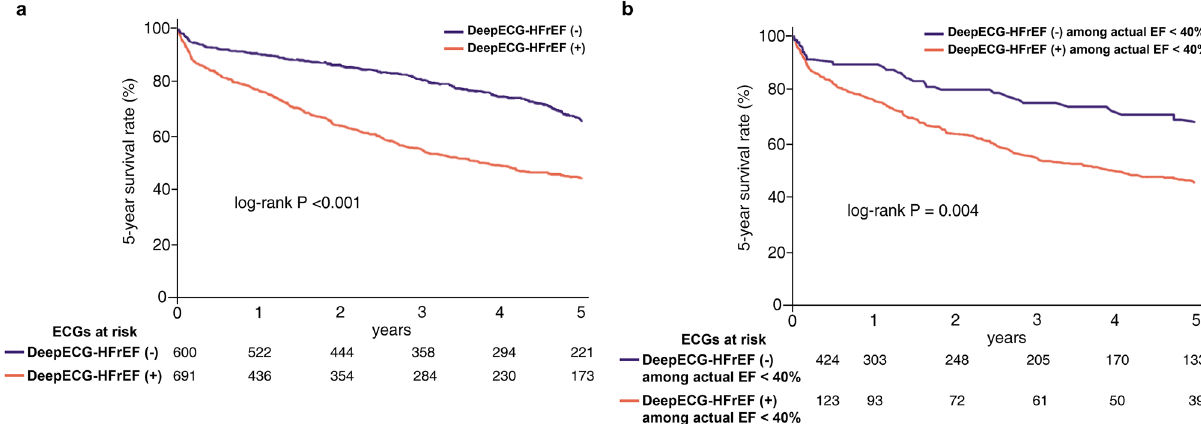
Figure 5. ( a ) Kaplan–Meier curve for mortality at 5-year follow up according to the DeepECG-HFrEF (Total ECGs = 1291) ( b ) Kaplan–Meier curve for mortality at 5-year follow up according to the DeepECG-HFrEF among patients with actual EF < 40%—The patients classified as DeepECG-HFrEF positive showed worse 5-year survival. ECG electrocardiogram; EF ejection fraction.